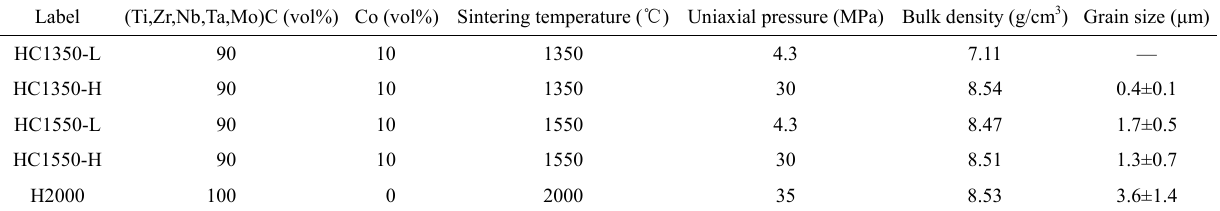
Table 1 Summary of the raw material compositions, sintering conditions, bulk densities, and grain sizes